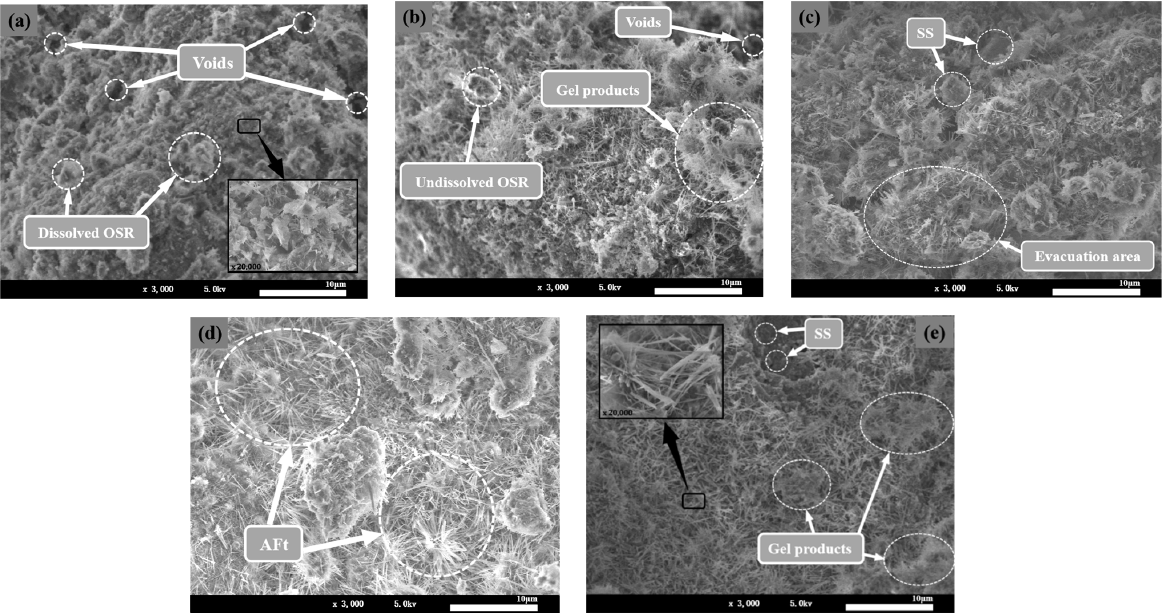
Figure 10. SEM images of COSGB at curing ages of 1 day ( a ), 3 days ( b ), 7 days ( c ), 14 days ( d ) and 28 days ( e ).